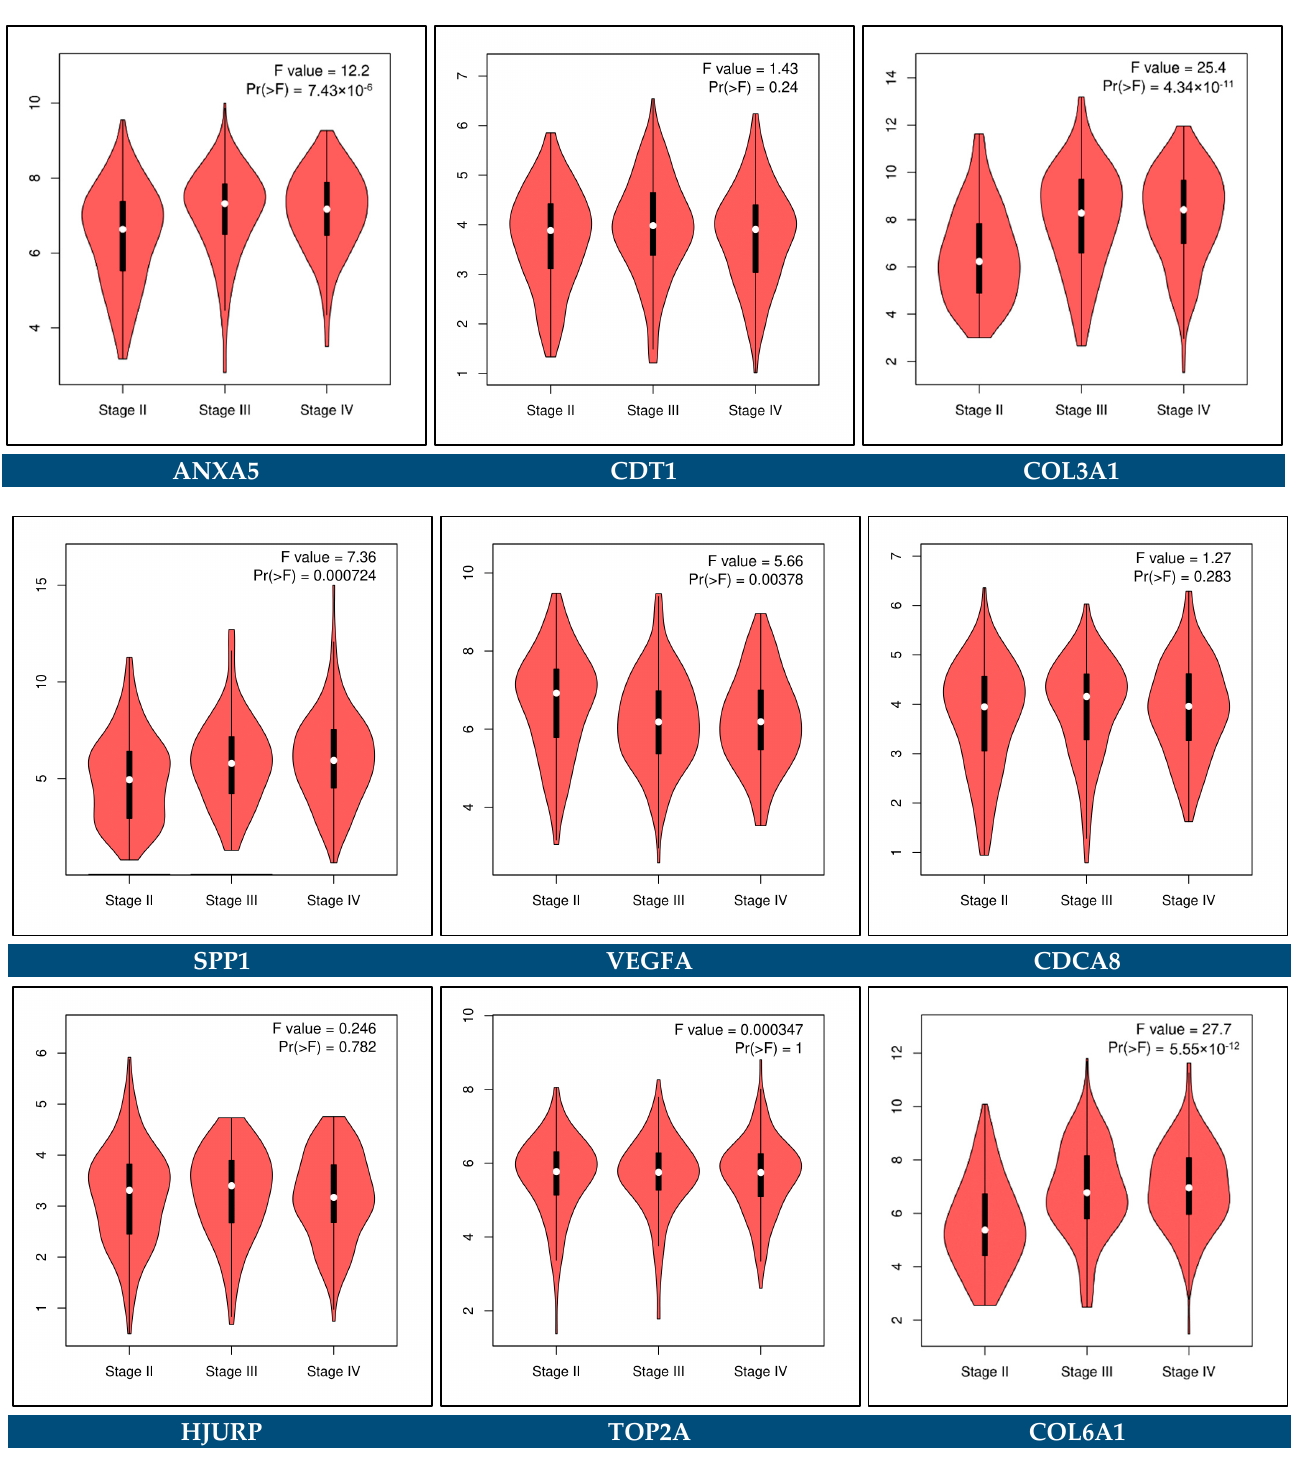
Figure 27. Violin plots representing the association between the expression levels of the nine key